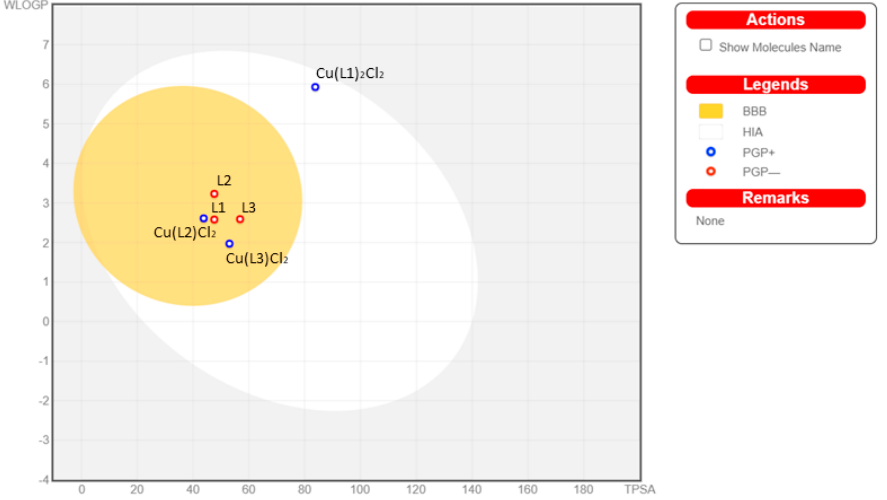
Figure 6. BOILED-Egg diagram for the synthesized ligands and complexes.